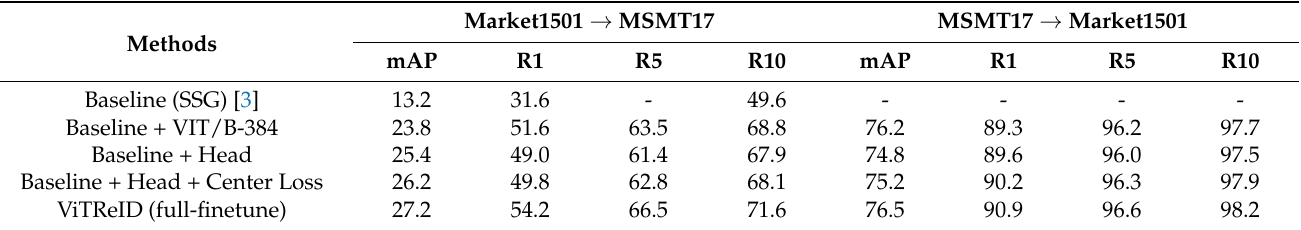
Table 4. Comparison of method performance with different parameter items (fine-tuned adds RandomGrayscale data enhancement